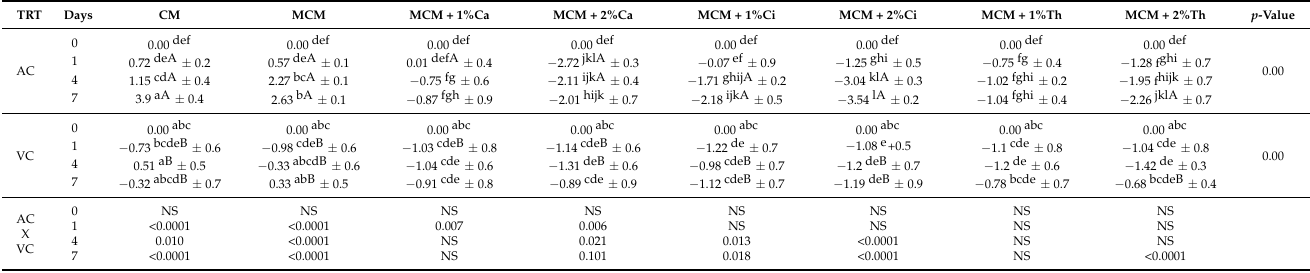
Table 9. Population changes of Pseudomonas (log (N0/N) ± SD CFU/g) in marinated camel meat with essential oils under aerobic (AC) and vacuum (VC) conditions after storage at 4 ◦ C for 0, 1, 4 and 7 days.